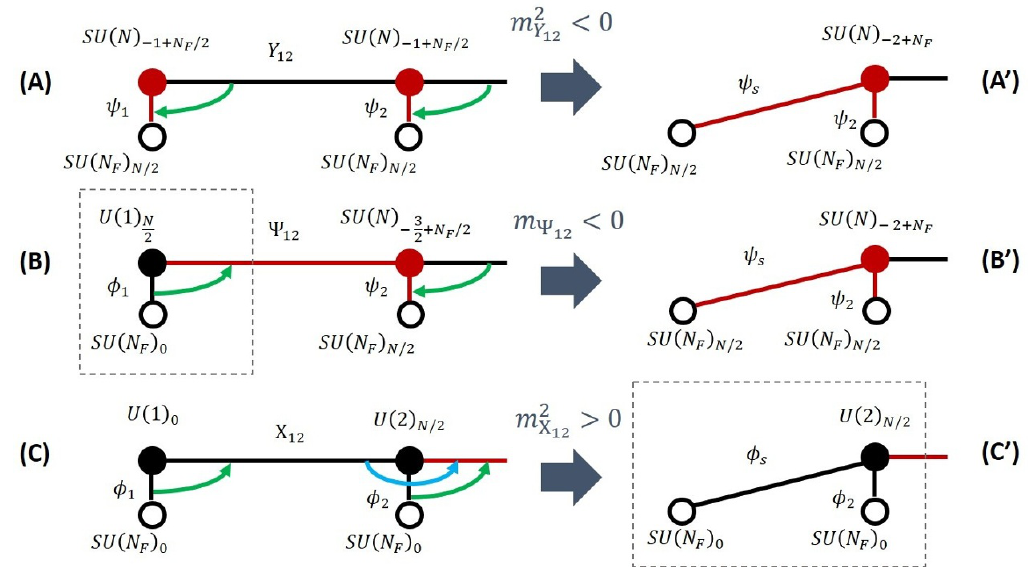
Figure 9. Explanation of interaction and enhanced (cid:13)avor symmetries which arise due to the (cid:13)avor-violated master duality and its (cid:12)nite interaction terms. We are using green/blue arrows to denote the (unidirectional) interactions. The green arrows represent (cid:12)nite interactions between the (cid:13)avor degrees of freedom and adjacent bifundamentals. The light blue arrows represent interactions between bifundamental scalars, which were also present in the pure YM case of [29]. We